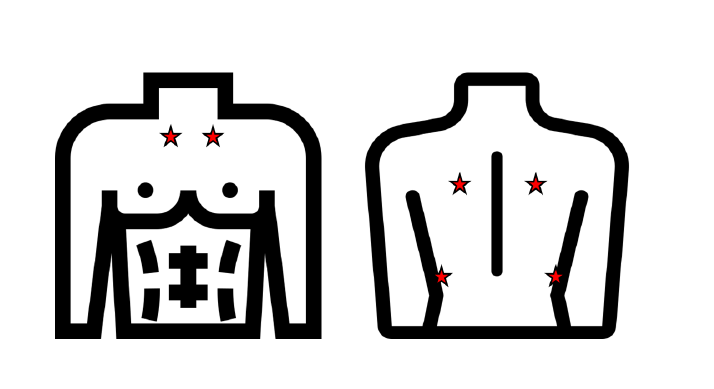
Figure 3. The sounds were recorded from seven different locations remarked in